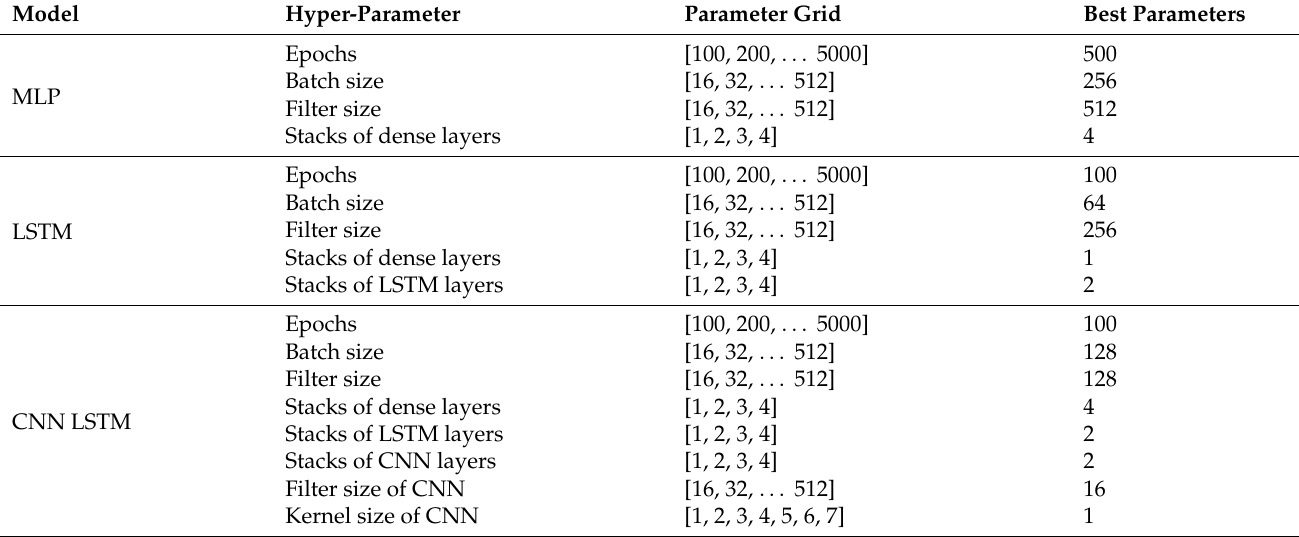
Table 3. Hyper-parameters for the proposed and benchmark